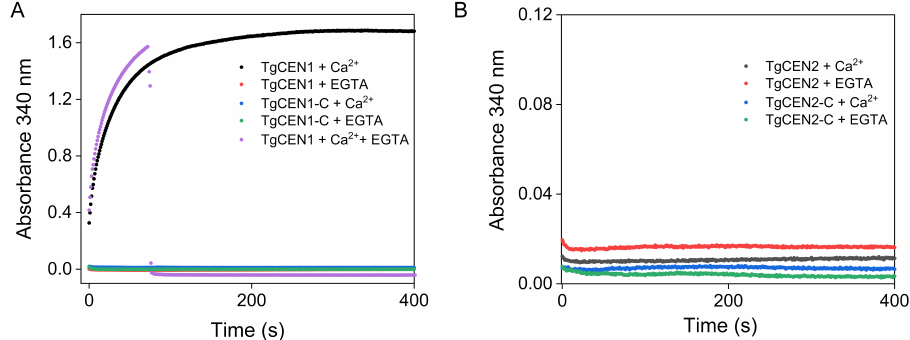
Figure 7. Turbidity measurements of full-length and truncated TgCEN1 ( A ) and full-length and truncated TgCEN2 ( B ). Scattering intensity at 340 nm was measured as a function of time at 37 ◦ C for the samples (20 µ M protein) with 1 mM Ca 2 + or 1 mM EGTA. ( A ) Representative association profiles of Ca 2 + -bound full-length TgCEN1 (black), apo-full-length TgCEN1 (red), Ca 2 + -bound TgCEN1-C (blue) and apo-TgCEN1-C (green). The e ff ect of EGTA on a solution of Ca 2 + -saturated full-length TgCEN1 is also shown (light violet). ( B ) Representative association profiles of Ca 2 + -bound full-length TgCEN2 (black), apo-full-length TgCEN2 (red), Ca 2 + -bound TgCEN2-C (blue) and apo-TgCEN2-C